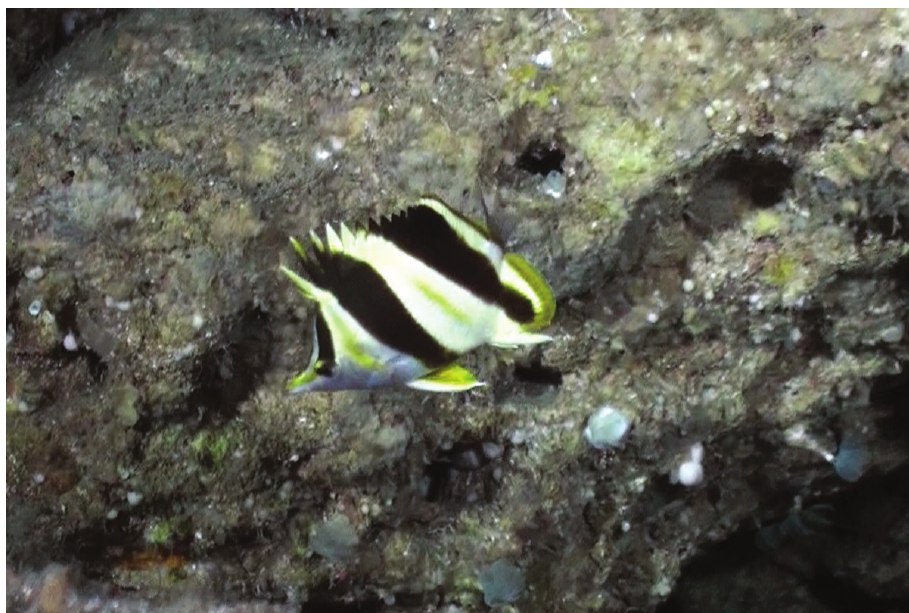
Figure 6. Prognathodes guezei at a depth of 117 m off Sodwana Bay, South Africa. Photo by R. L.